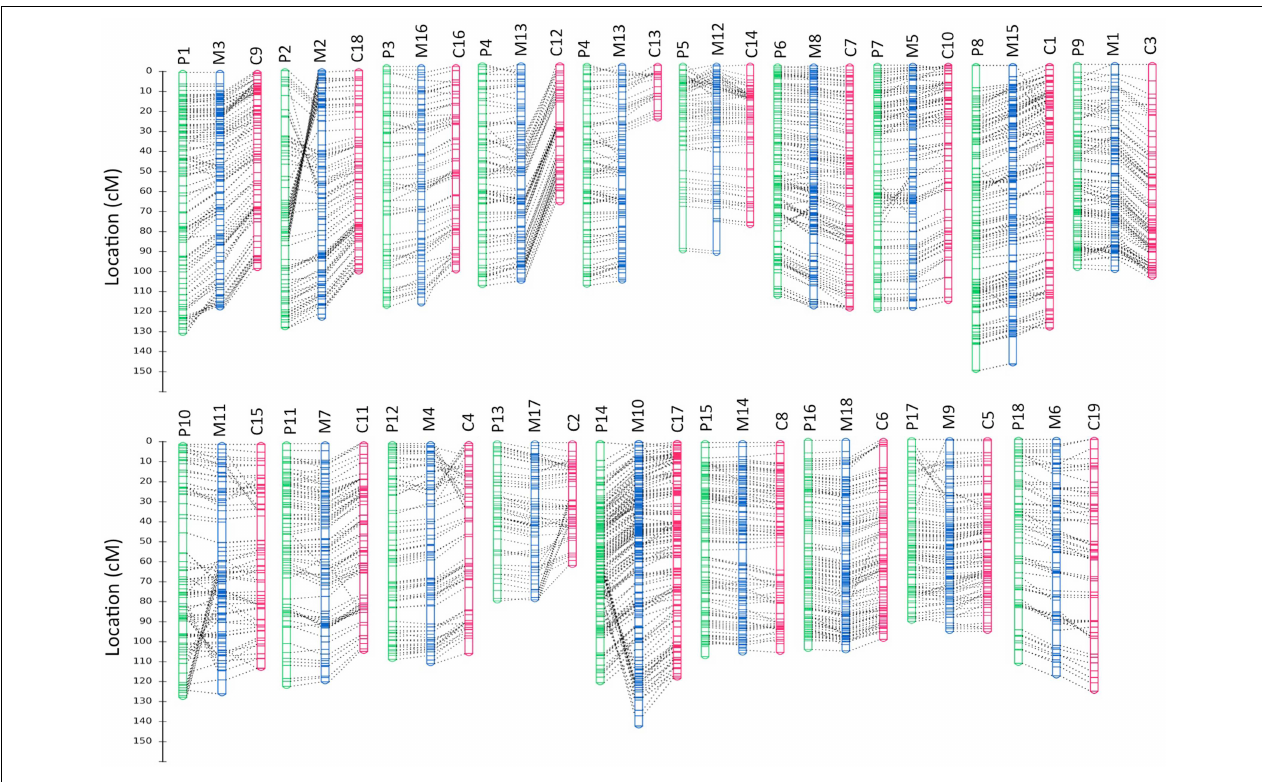
FIGURE 3 | Comparison of homologous linkage groups from the component and integrated genetic maps. Linkage groups from BPM24 × RRIM600 (population P), BPM24 × RRIC110 (population C) and the merged map are displayed in green, magenta and blue, respectively. The genetic positions of SNP markers are shown on the left